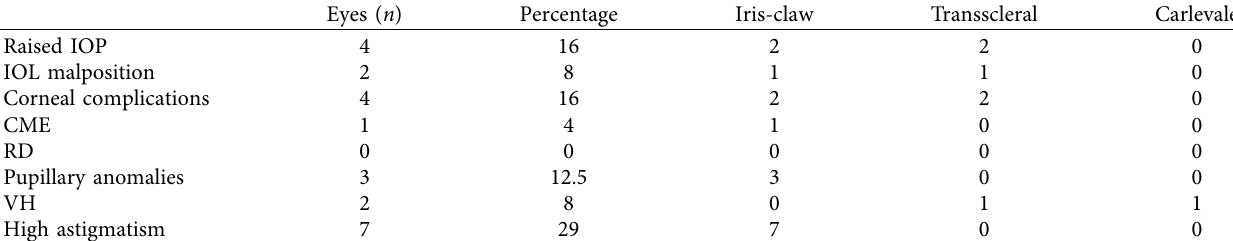
Table 5: Incidence of complications related to the lens